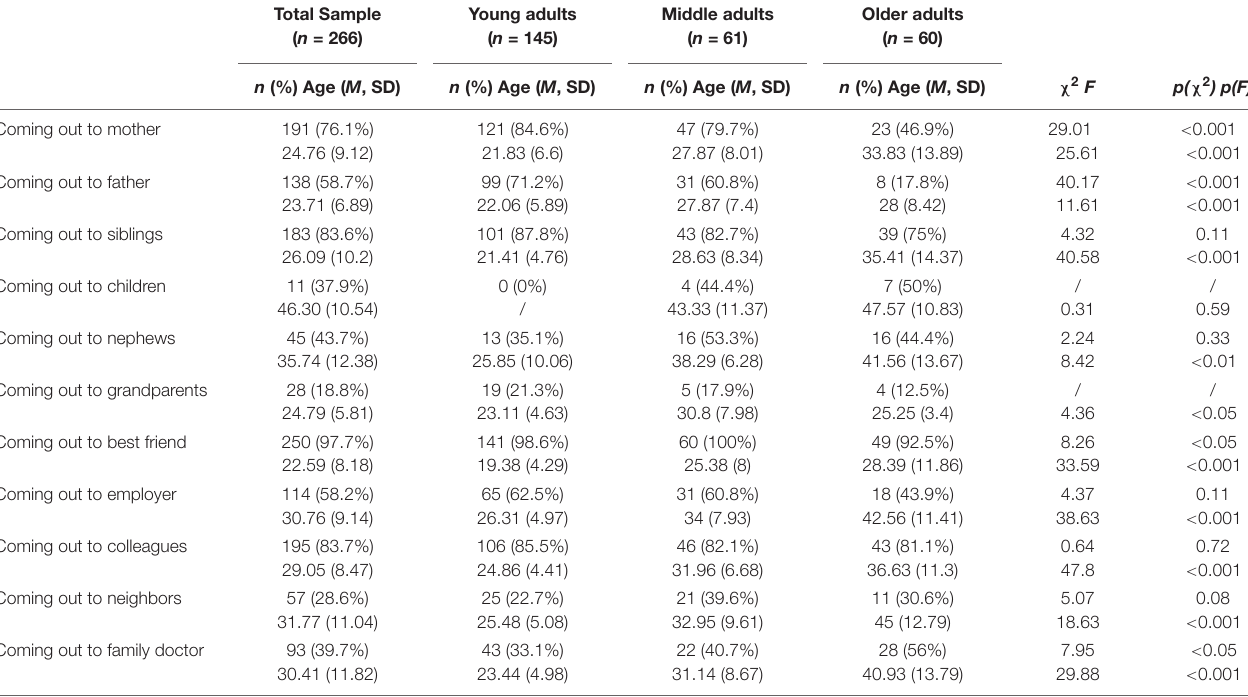
TABLE 3 | Differences between young, middle, and older LGBQ+ adults in rate and average age of coming out (CO) with significant